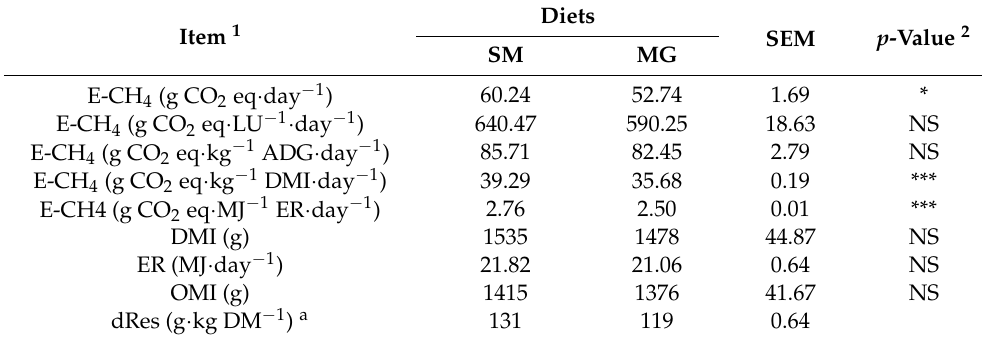
Table 6. Mean E-CH 4 level (g CO 2 eq) ± SEM and regression model in pigs fed a standard level of fiber (SM diet) or a diet based on a high level of fiber (MG